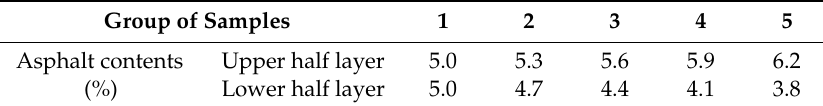
Table 3. The asphalt contents of five groups of specimens.